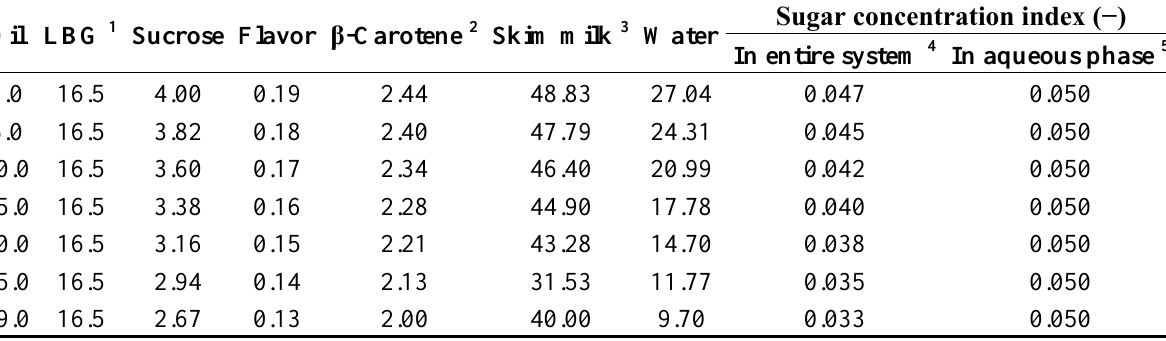
Table 1. Formulation (g/100 g) of the emulsions with different fat